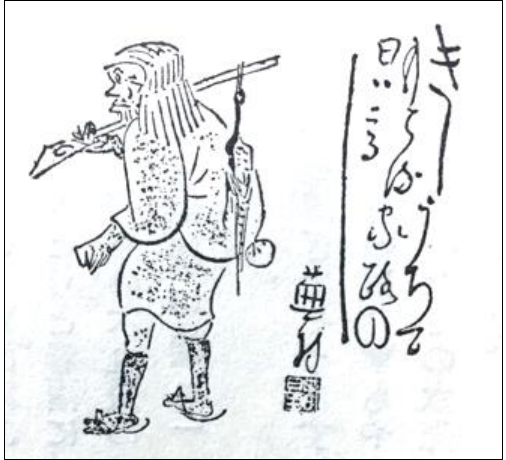
Figure 2. Buson’s illustration of a hunter with a pheasant (left), followed by his inscription “ Kiji uchite / modoru ieji no / hi wa takashi ” (right). See BZ , 1: 275. For a larger image, see BZ , 6: